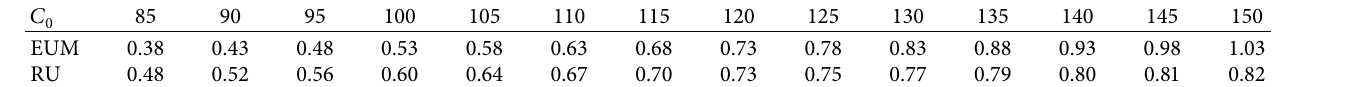
Table 10: Comparison of RU and EUM ( T